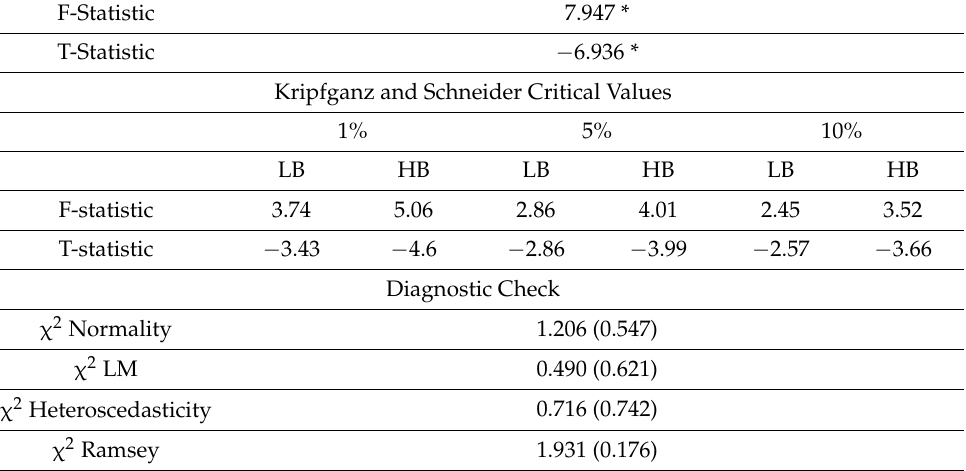
Table 5. ARDL approach to cointegration.